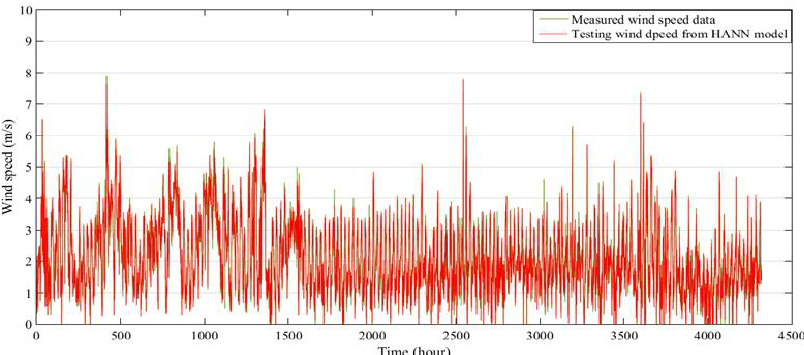
Figure 19. Comparison between measured and predicted hourly wind speed data for six months at Kuala Terengganu, for validation of the HANN model. Table 5. Statistical errors generated by the ANN model and the proposed HANN model.